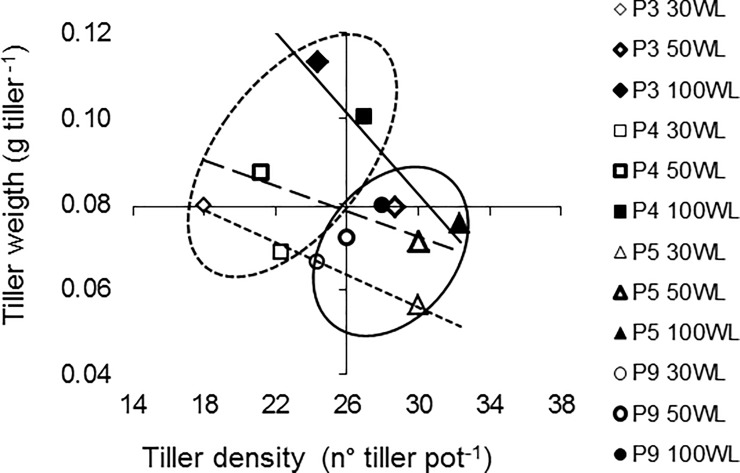
Relationship between density and weight of tillers (axes in average values) for the populations (P3, P4, P5, P9) under different water levels (WL: 100, 50, 30).Each symbol is the mean of n = 3. The circles enclose populations with similar canopy morphological pattern (cut line, P3 and P4 with bigger size and fewer tillers, and continuous line, P5 and P9 with smaller size and more tillers). The lines between density and weight of tillers show the response of populations watered with the same water level (100WL continuous line, 50WL cut line and 30WL dotted line).